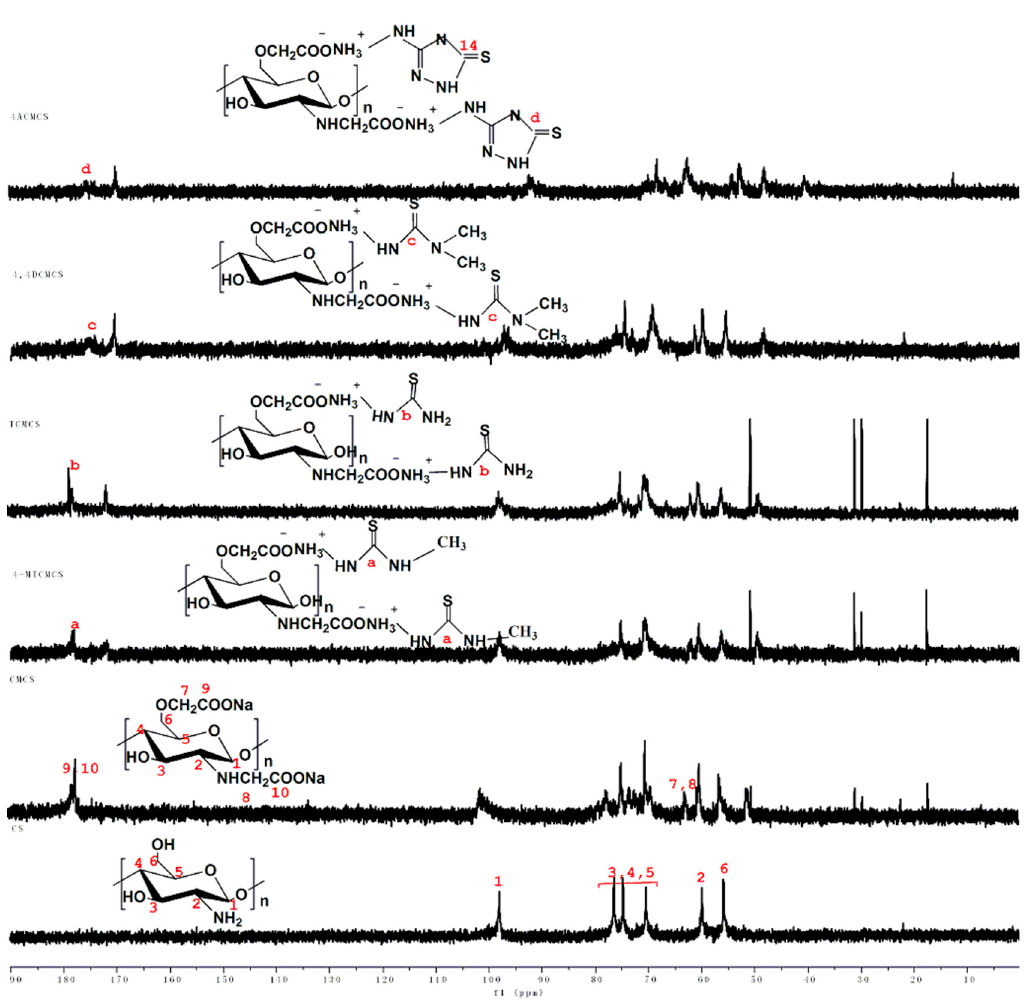
Figure 3. 13 C NMR spectra of CS, N, O-CMCS, and Carboxymethyl chitosan containing thiourea salts.